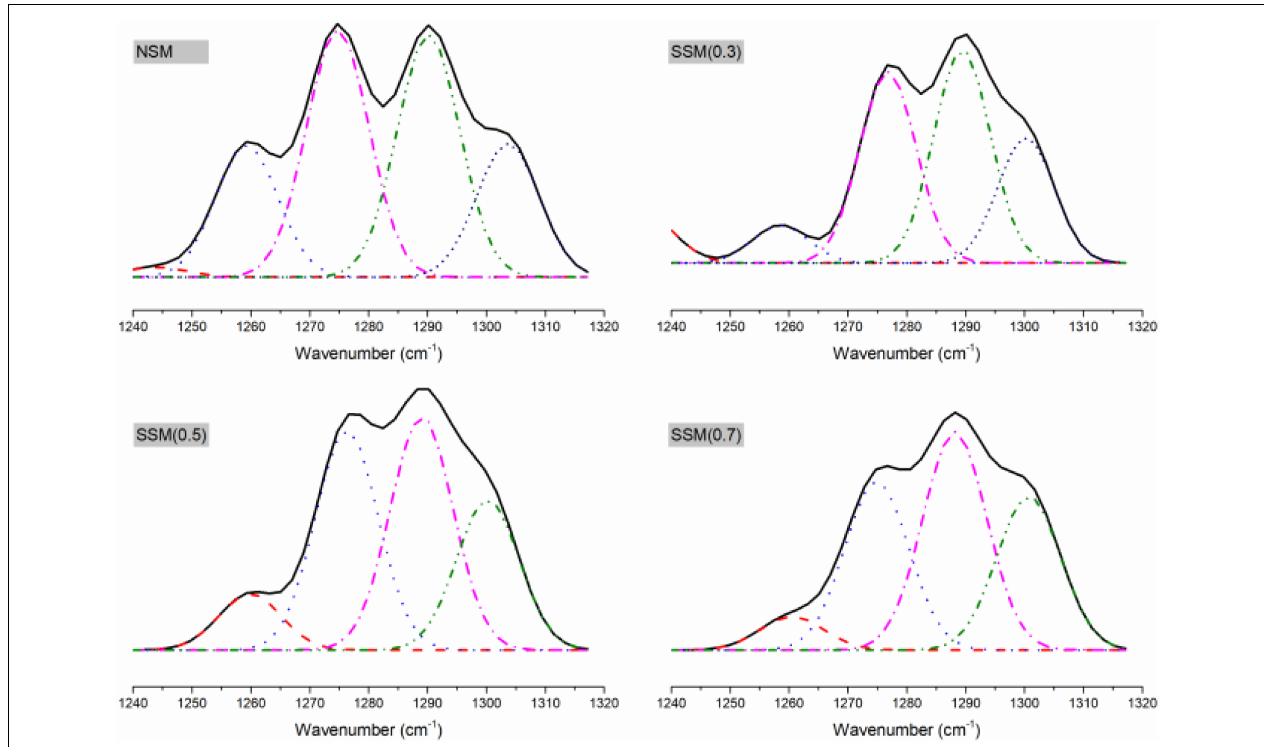
FIGURE 5 | The Fourier transform infrared spectroscopy (FTIR) peak resolution of amide III spectral regions, 1320–1240 cm − 1 . NSM, native soybean meal; SSM, steam-exploded soybean meal, SSM (0.3), SSM (0.5), and SSM (0.7) indicated steam explosion pressure were 0.3, 0.5, and 0.7 MPa, respectively.